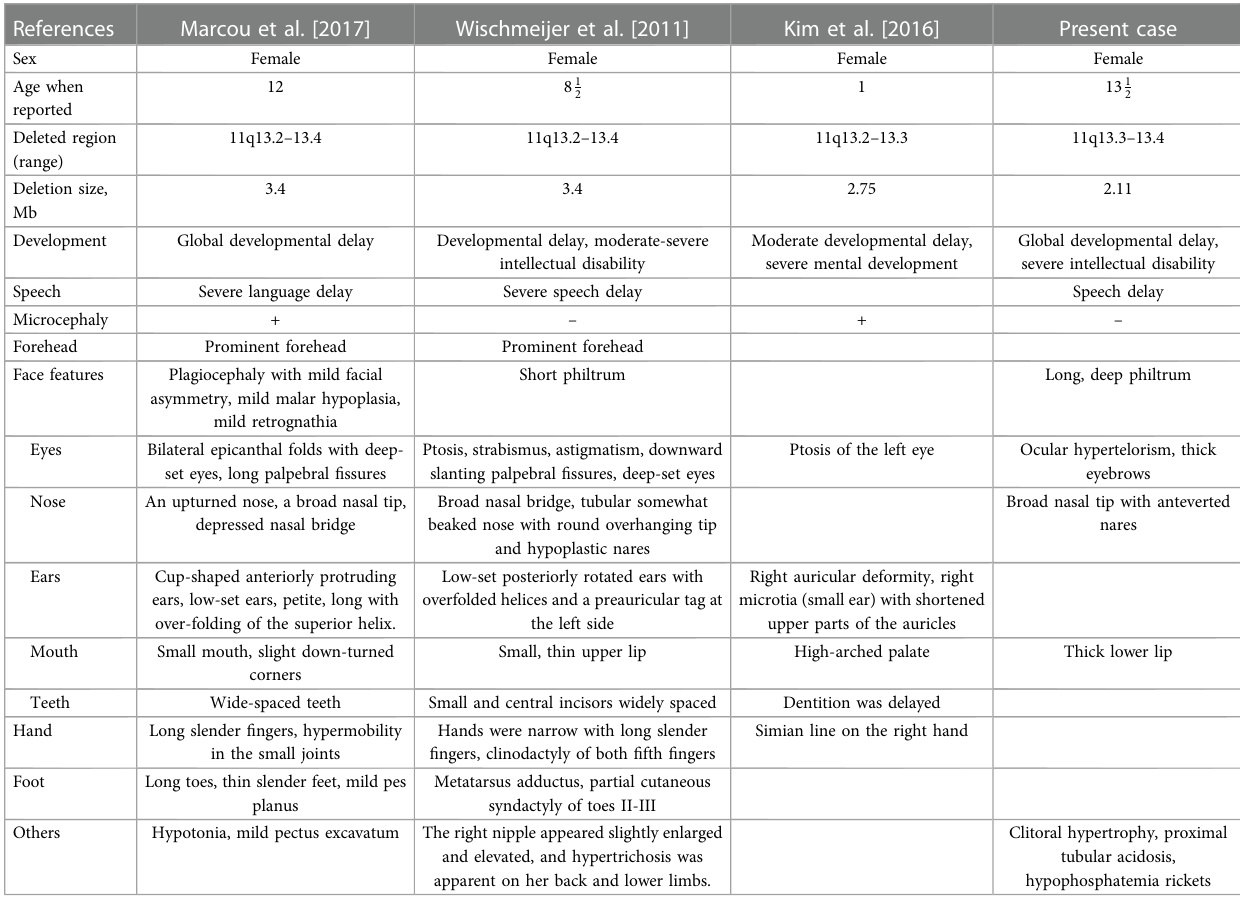
TABLE 2 Clinical features of reported cases with deletions comprising chromosome 11q13.2 –